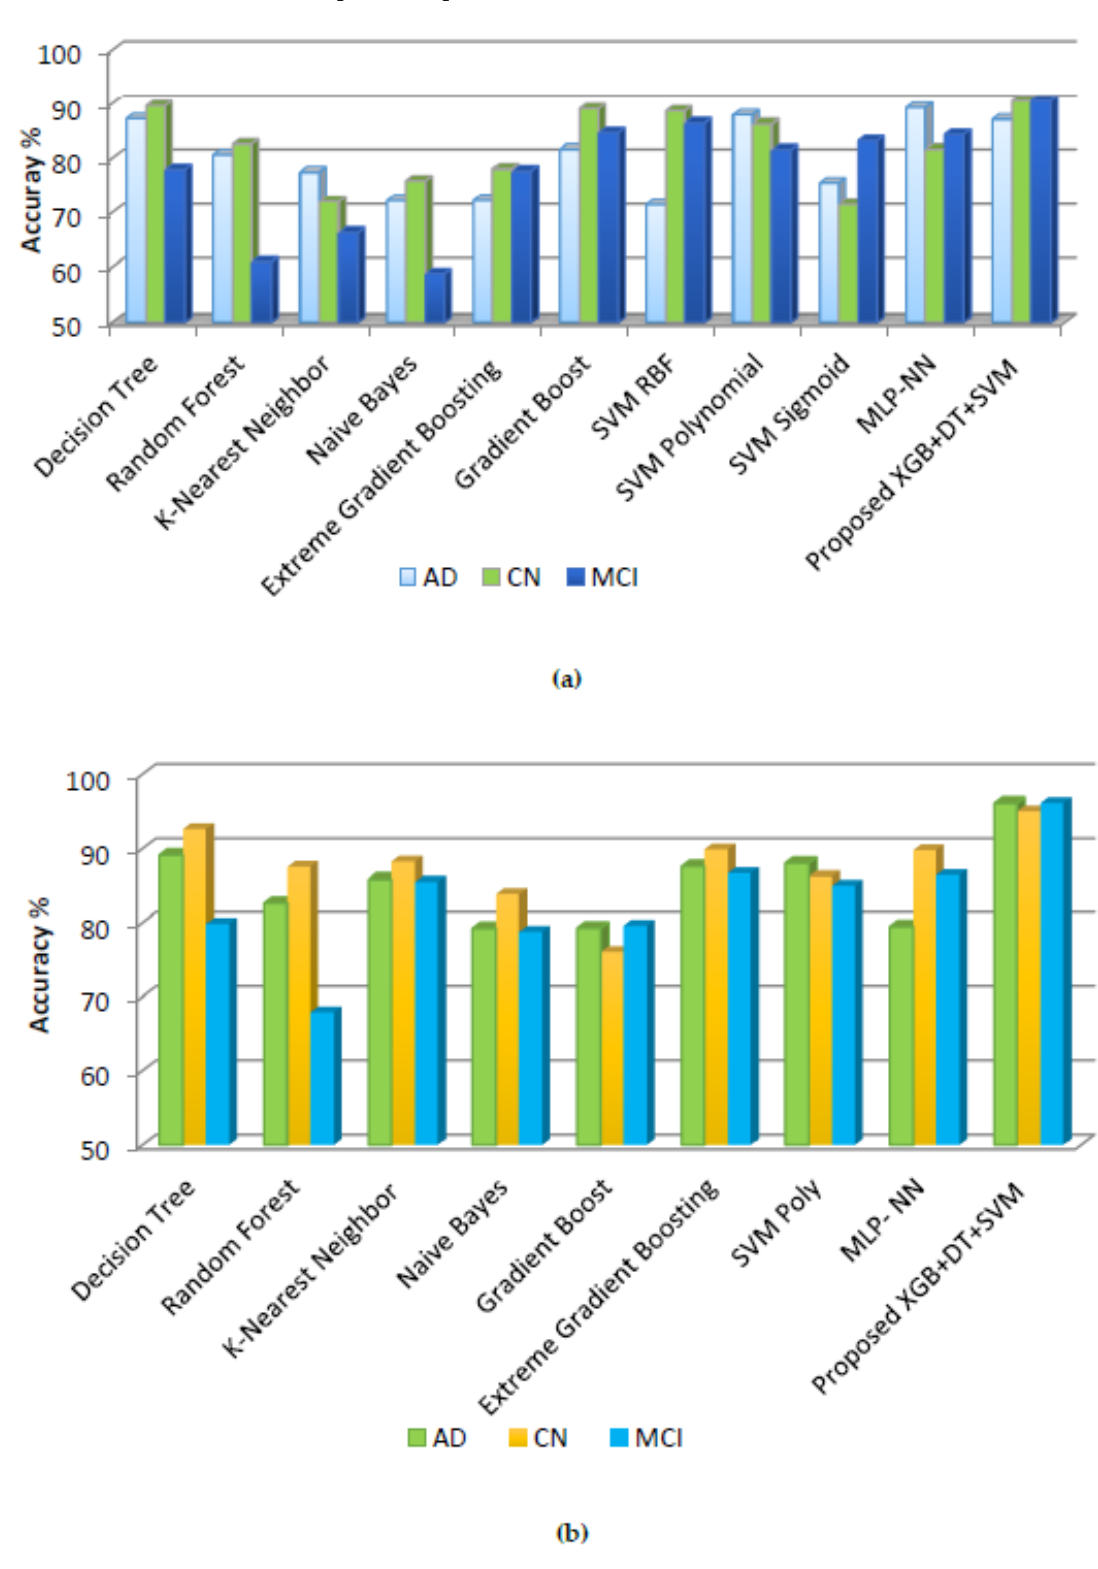
Figure 8. Comparative performance evaluations among classical ML models and XGB + DT + SVM ensemble based on classification accuracy ( a ) before using Grid Search, ( b ) after using Grid Search.